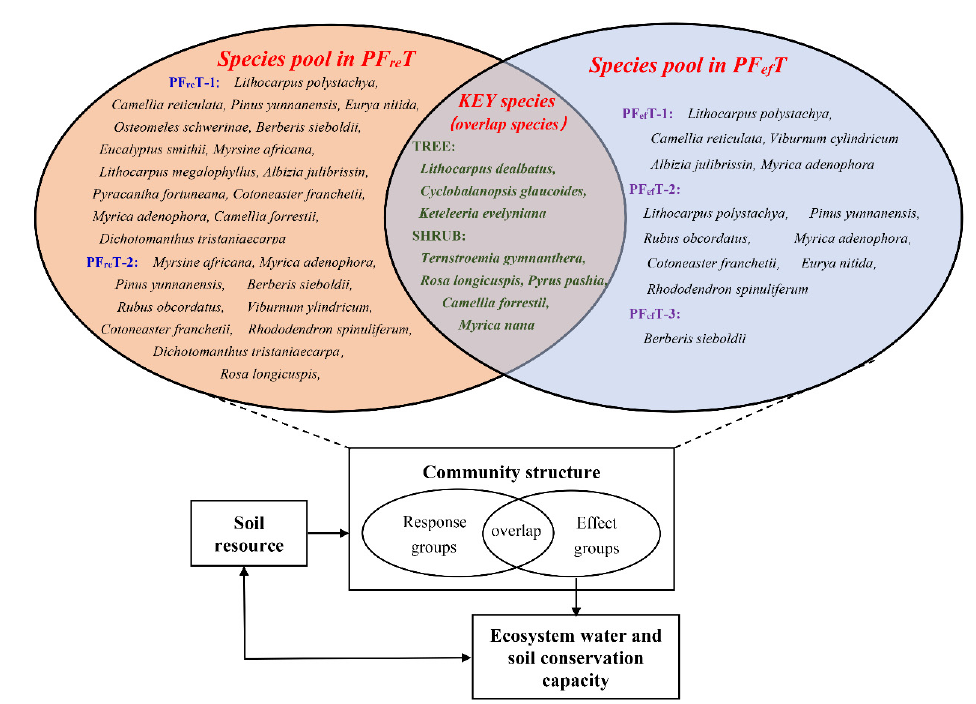
Figure 1. Species pools of PF re Ts and PF ef Ts and the identification of key restoration species using a trait-based response-and-effect framework.